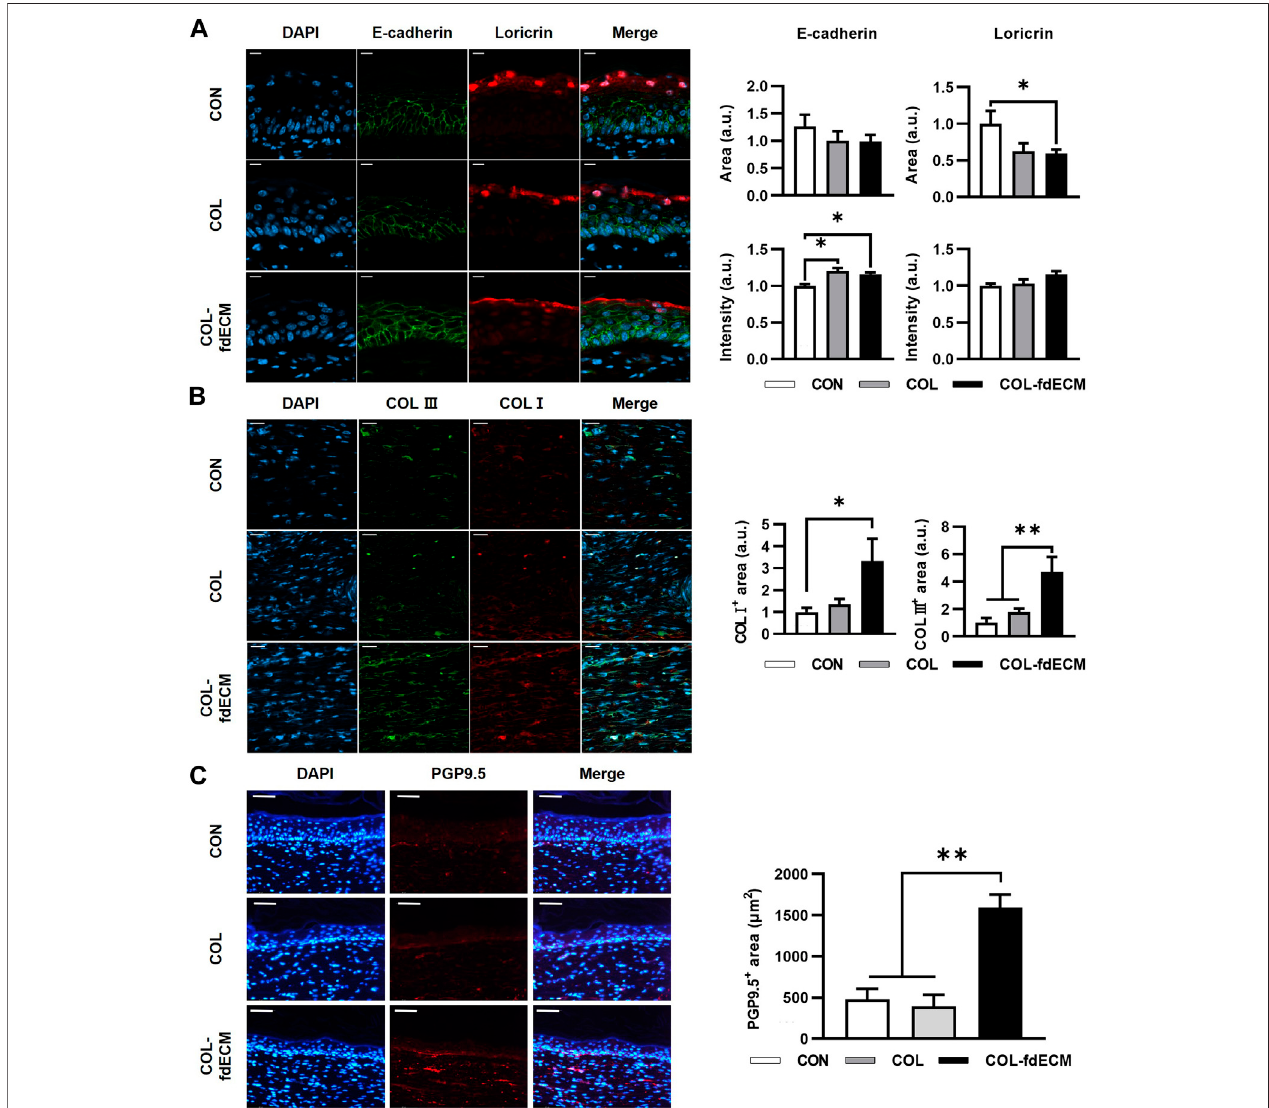
FIGURE3| Tissueremodelinginskinwoundafter21 daysoffdECMtreatment. (A) Immuno fl uorescenceimageandsemi-quantitativeanalysisofbarrierfunctionof epidermis stained with E-cadherin (green) and loricrin (red). Scale bar represents 10 μ m. (B) Representative images of double immuno fl uorescence staining against collagen I (COL I, red) and collagen III (COL III, green). Semi-quantitative analysis was performed by measuring the positive area. Scale bar represents 20 μ m. (C) Immuno fl uorescence image and semi-quantitative analysis of nerve fi ber in dermis stained with PGP9.5 (red). Scale bar represents 50 μ m. Bar represents mean ± standard error of mean (SEM). * p < 0.05, ** p <